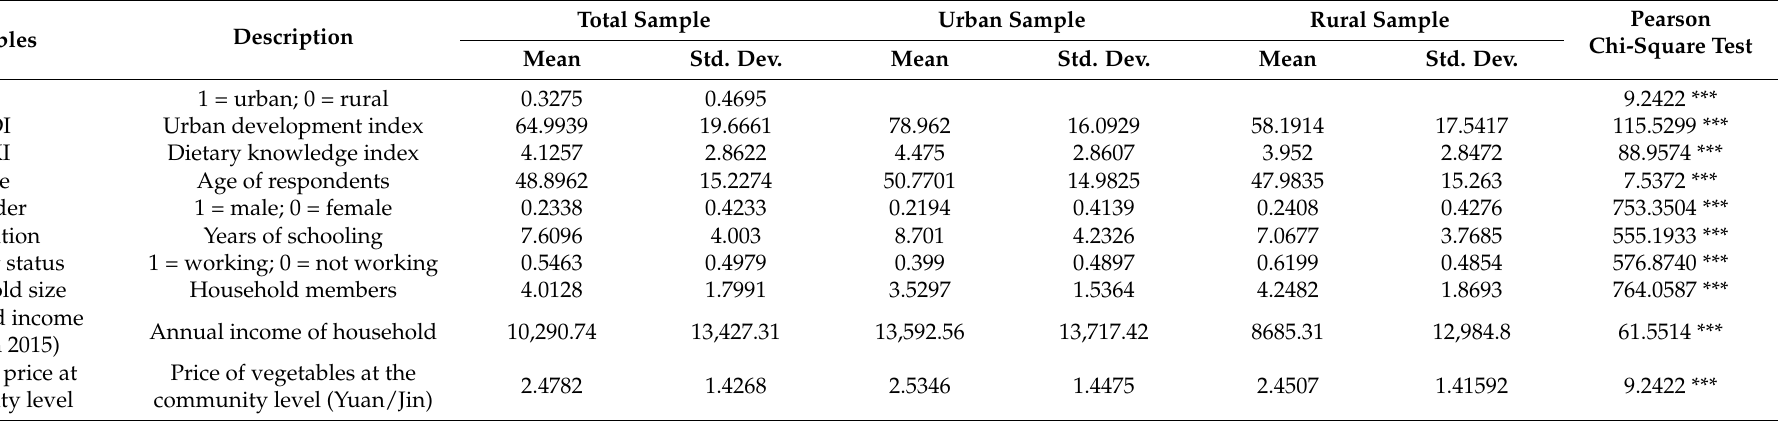
Table 3. Descriptive statistics of independent